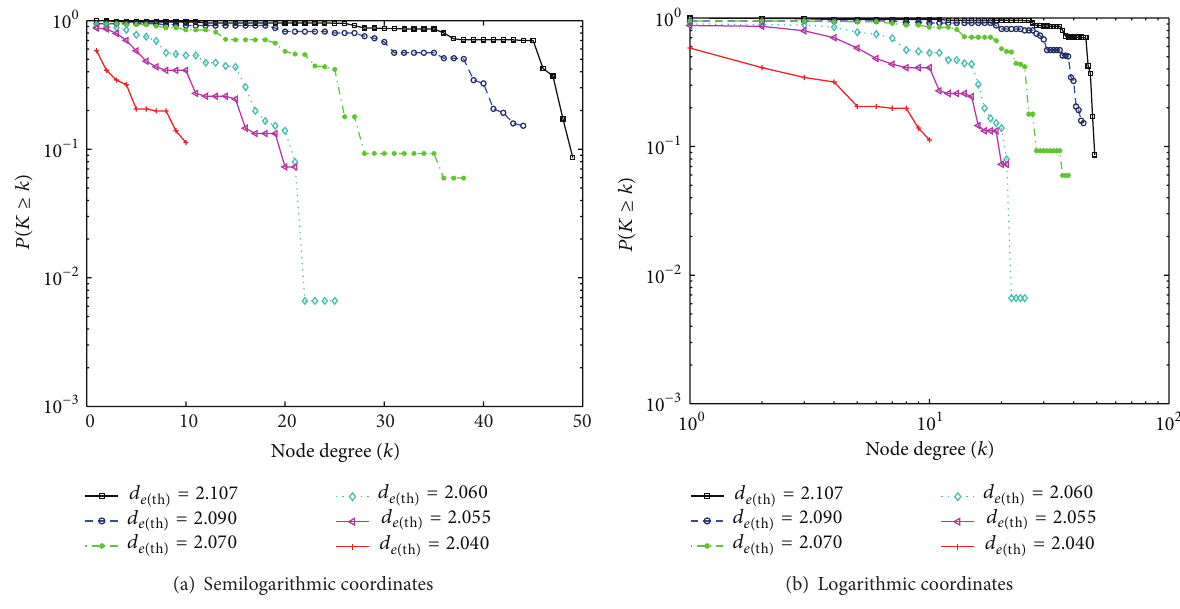
Figure 8: Cumulative degree distribution of electrical distance-based network model of TJ220 Grid.